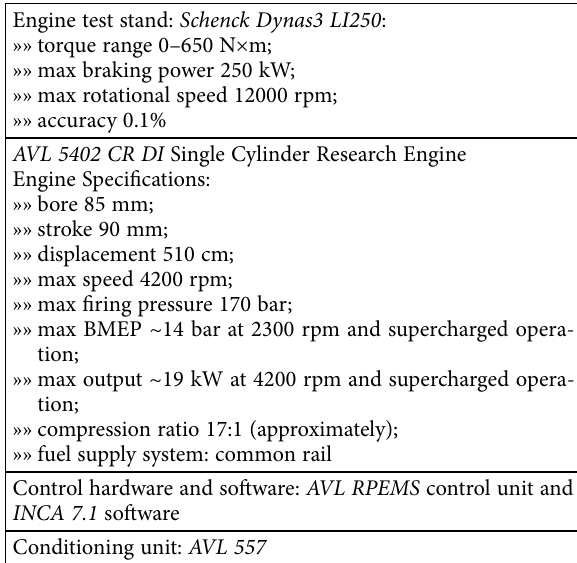
Figure 2. Test equipment: 1 – the engine test bench Schenck Dynas3 LI 250 ; 2 – the compression ignition engine AVL 5402 ; 3 – the AVL 7351 fuel consumption measuring unit; 4 – the gas injection system Table 1. Technical data for the test engine and test